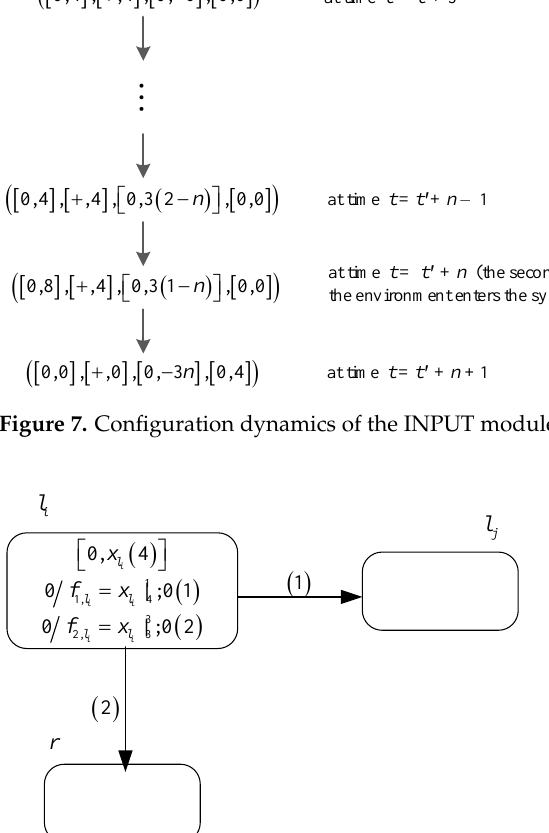
Figure 8. The deterministic ADD module in system Π 2